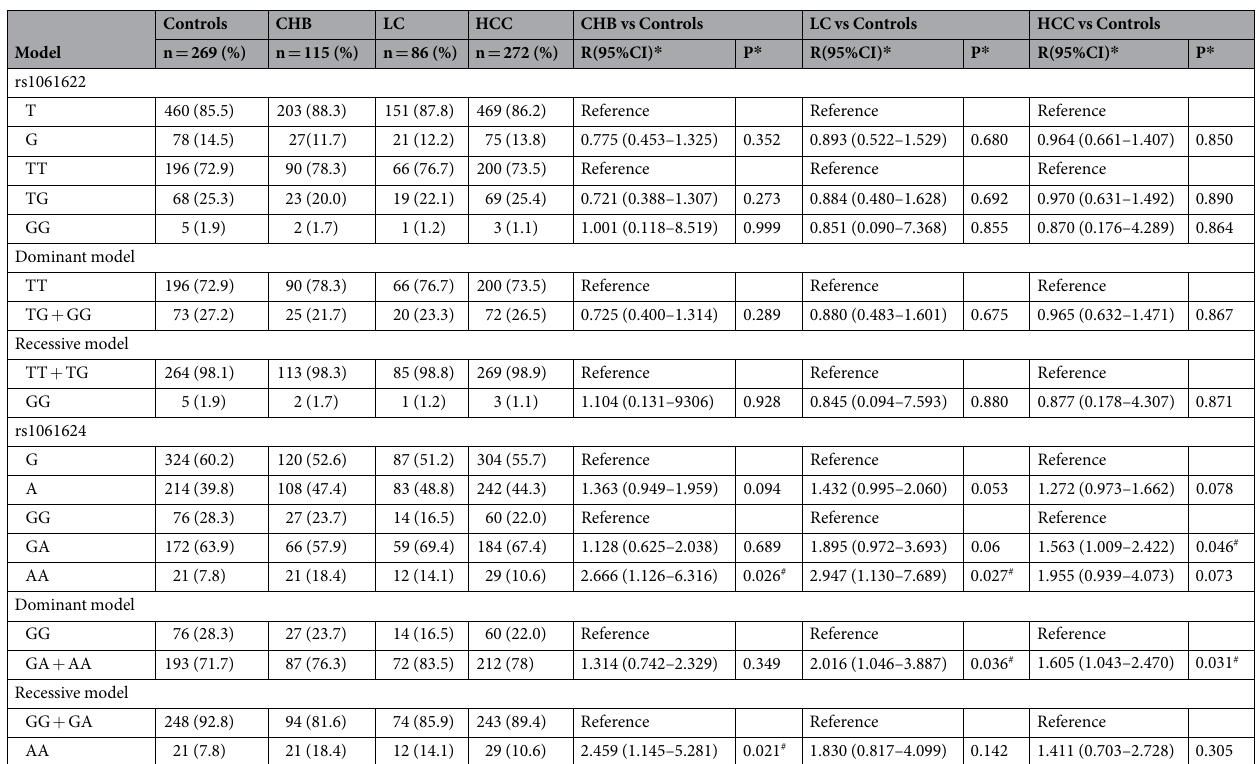
Table 2. Genotype Distributions and Allele Frequencies of TNFR2 Polymorphisms Between Cases and Controls. * Adjusted for age, gender, ethnicity, smoking, alcohol consumption,and BMI. # The data reach statistical